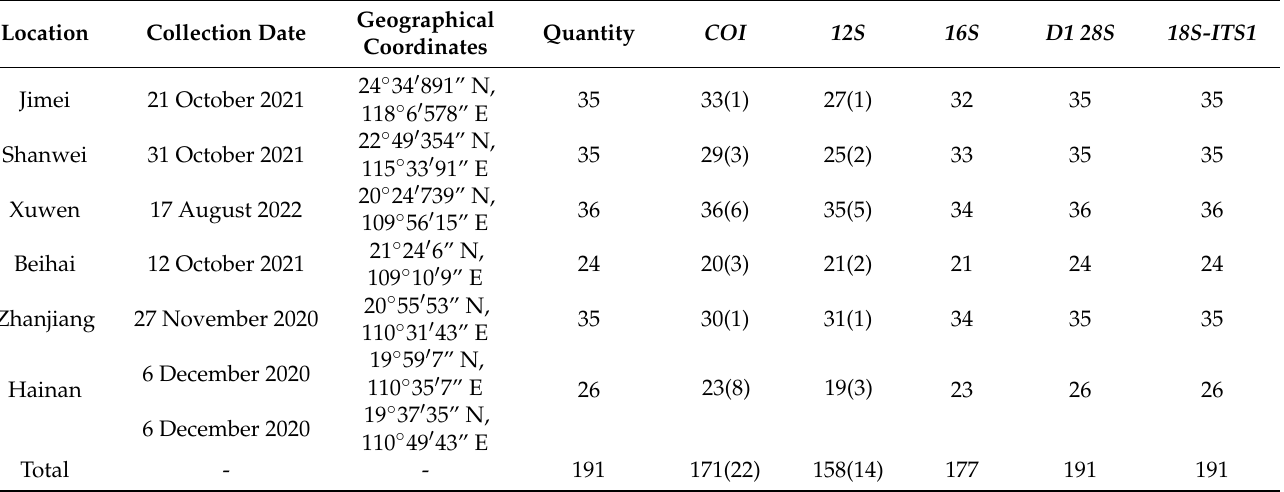
Table 2. Primers and thermal cycling conditions for the PCR reactions of the COI , 12S , 16S , D1 28S , and 18S-ITS1 sequences in this study.